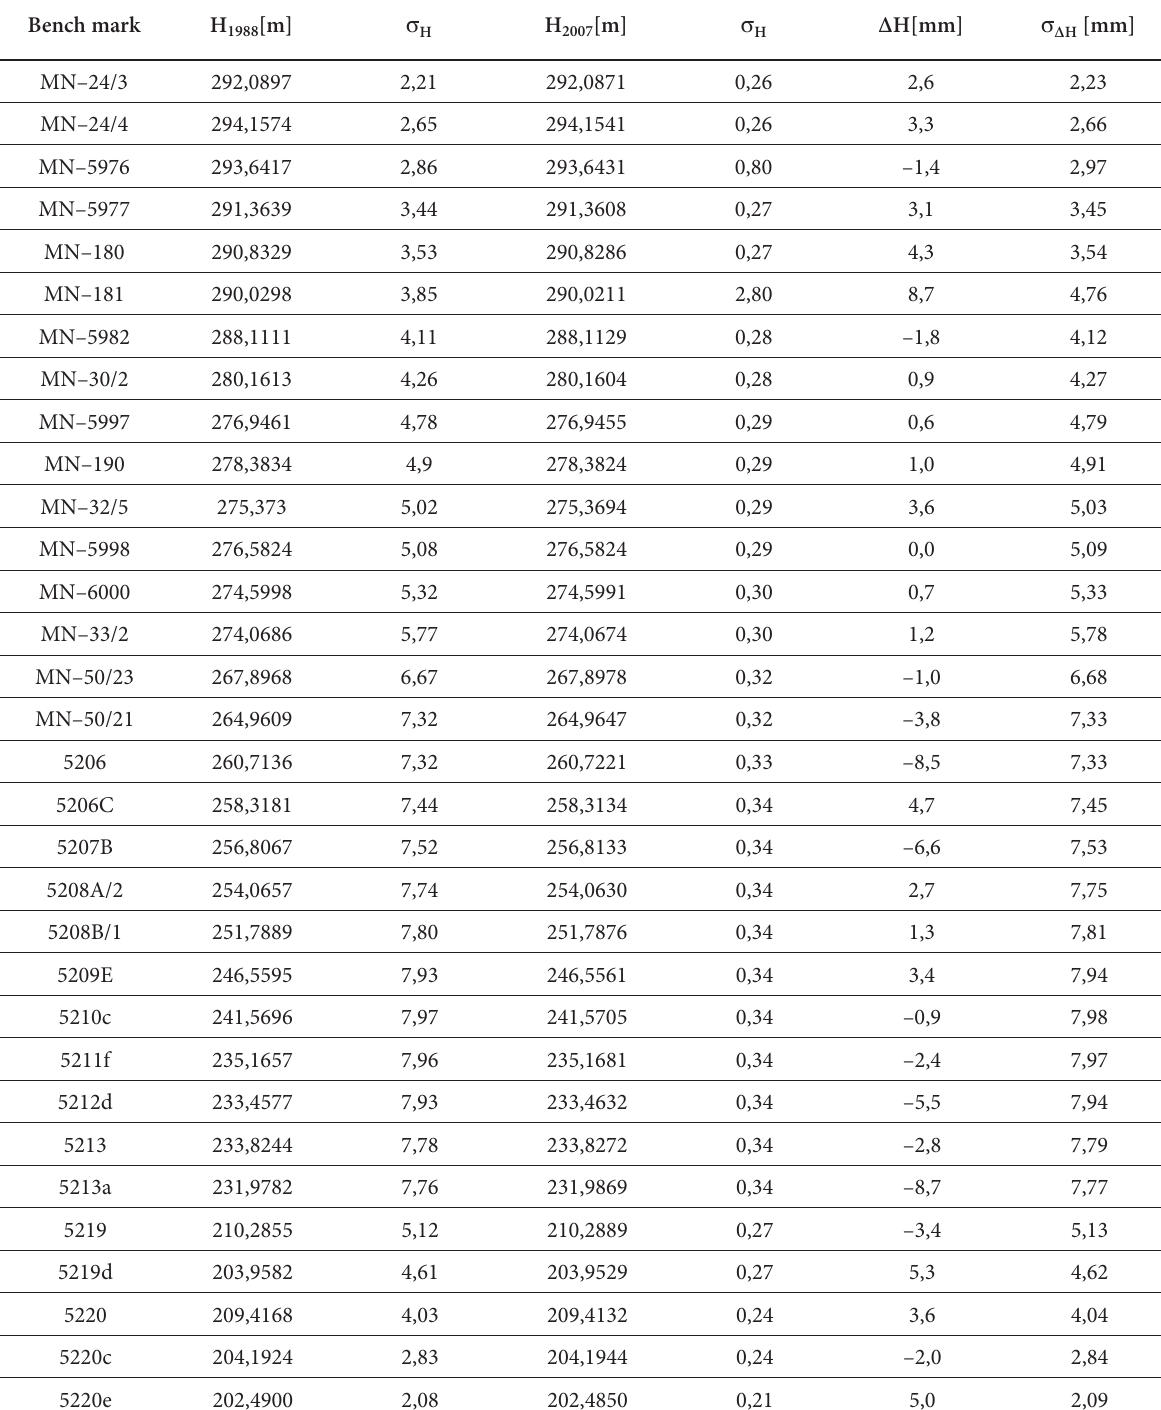
Table 8. Altitudes of bench marks, vertical displacements of bench marks and accuracy